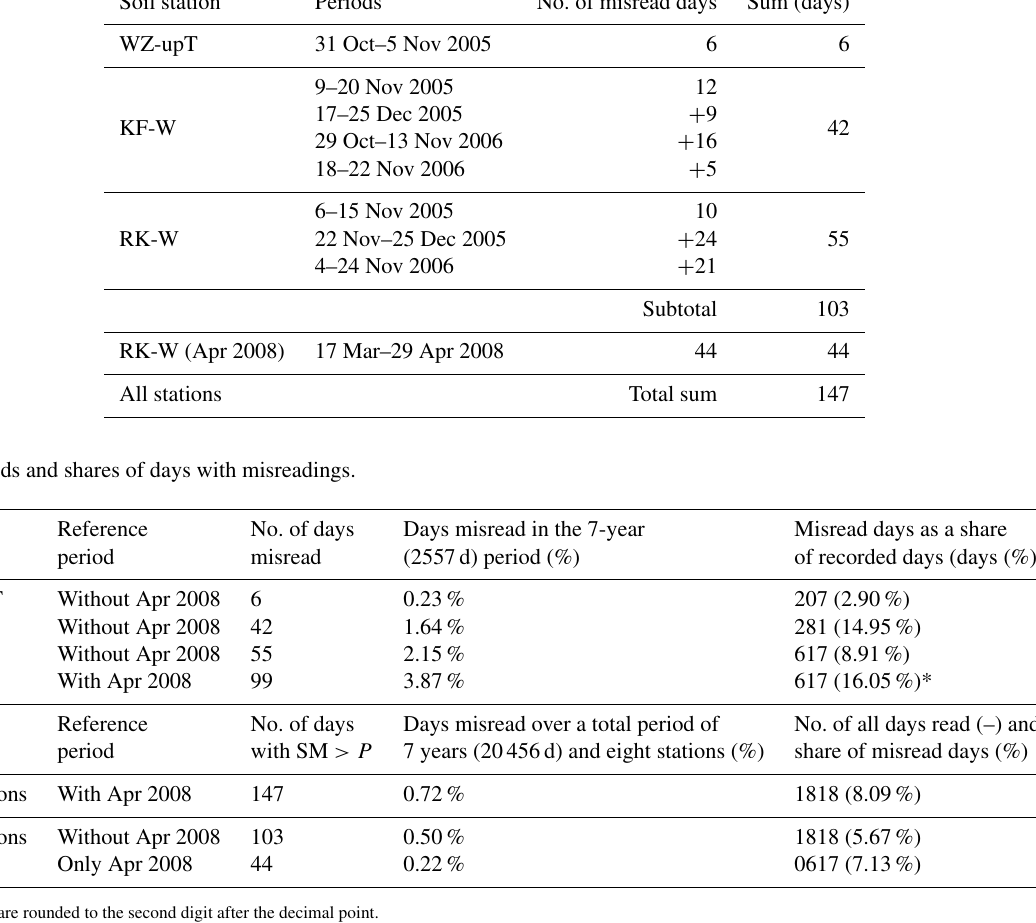
Percentages are rounded to the second digit after the decimal point.